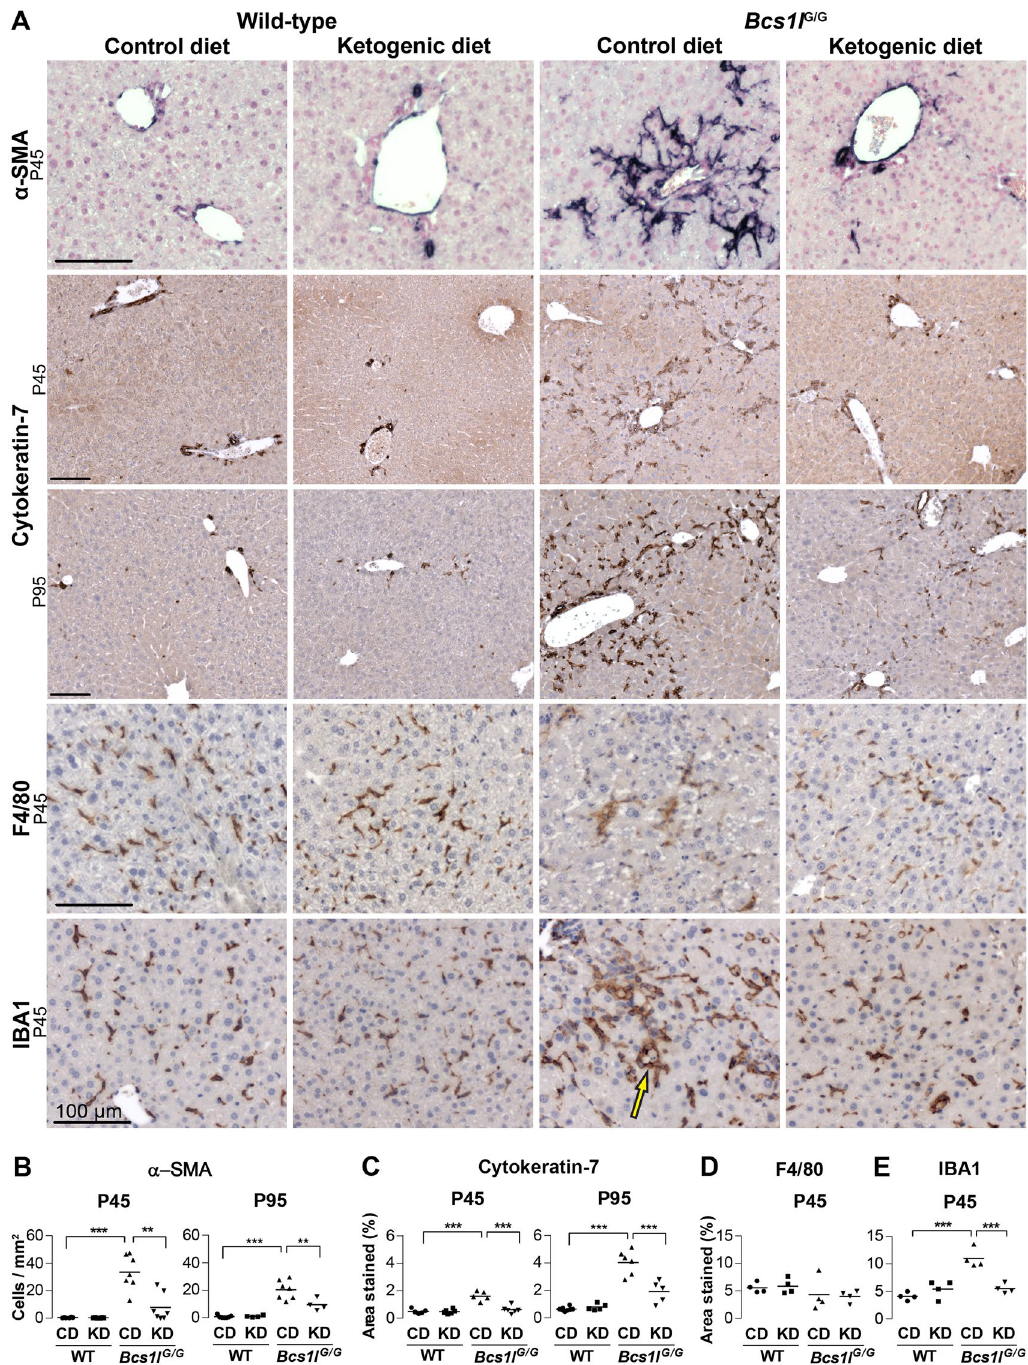
Figure 2. Ketogenic diet modulates activation of hepatic progenitor cells, stellate cells and liver macrophages in Bcs1l G/G mice. ( A ) Immunostainings of liver sections for hepatic progenitor cell and bile duct marker cytokeratin-7; activated stellate cell marker α -smooth muscle actin ( α -SMA) and macrophage markers F4/80 and IBA1. ( A,B ) In wild-type livers α -SMA staining (dark blue) is seen only in the smooth muscle layer of arterioles but in the Bcs1l G/G mice on CD staining appears in numerous activated spindle-like stellate cells. In the Bcs1l G/G mice on KD the stellate cell α -SMA signal is diminished. ( A, C ) In wild-type livers cytokeratin-7 staining (dark brown) is only seen in bile ducts whereas in Bcs1l G/G livers the staining is present in numerous cells in the liver parenchyma. The abnormal staining is almost completely absent in the Bcs1l G/G mice on KD at P45. ( A,D,E ) F4/80 and IBA1 stainings (dark brown) show normal Kupffer cells in wild-type livers. IBA1 staining is increased in Bcs1l G/G livers but normalized by KD. Characteristic IBA1-positive macrophages surrounding a hepatocyte (crown-like structure, arrow) in Bcs1l G/G mice. All scale bars present 100 μ m. ** p < 0.01; *** p <